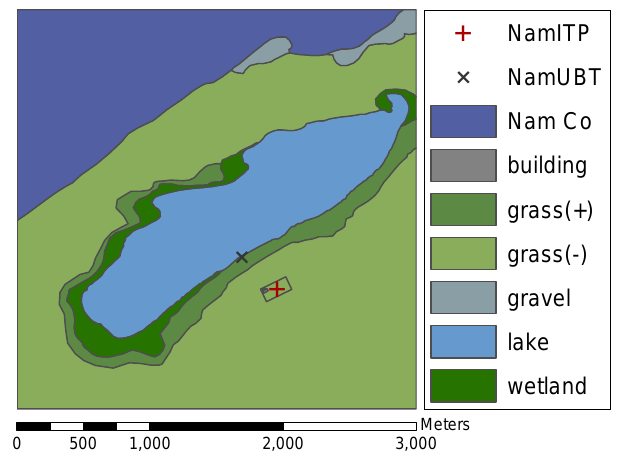
Fig. 1. Landcover map of study area: the black cross indicates the station identified as UBT, close to the small lake with denser surface cover [grass (+)], the red cross shows the station location ITP with sparse surface cover [grass